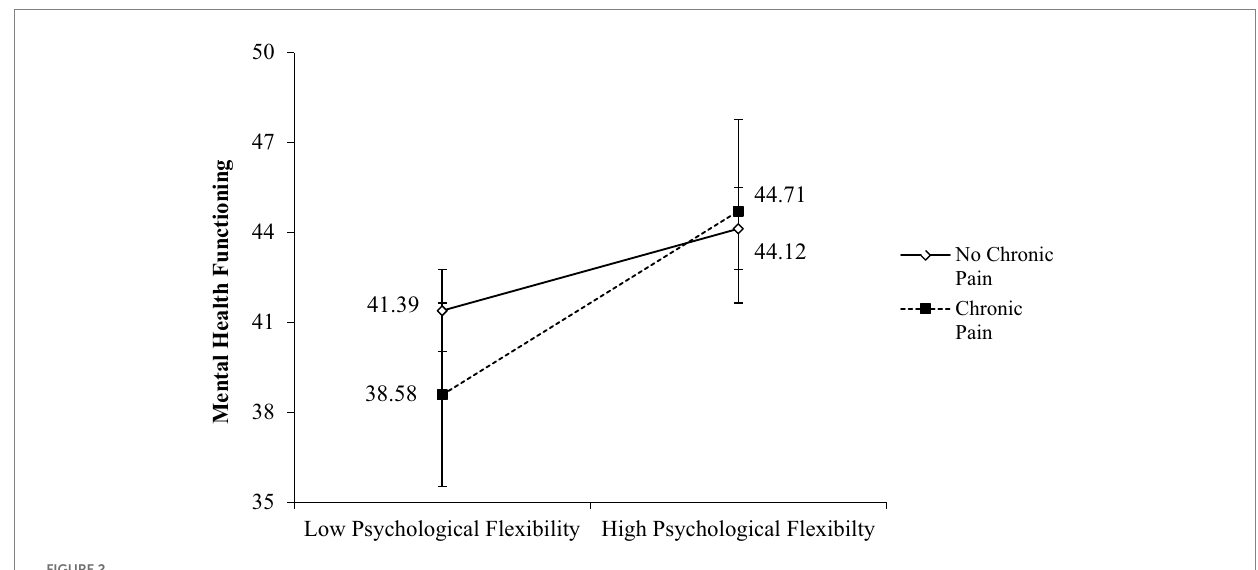
FIGURE 2 Interaction of psychological flexibility and chronic pain on mental health